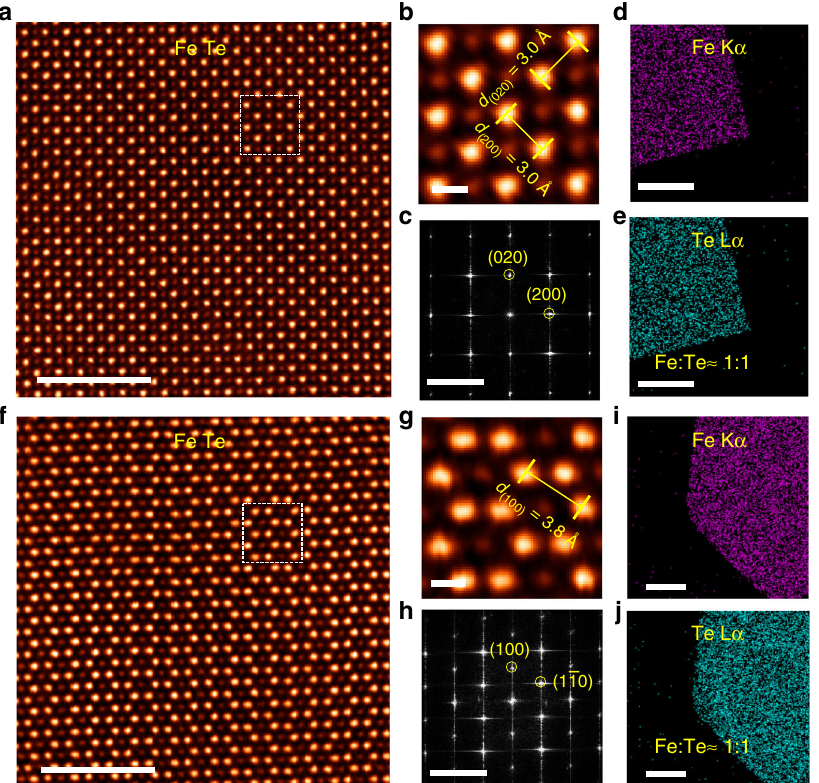
Fig. 3 Atomic morphology of tetragonal and hexagonal-shaped FeTe crystals. a , f Atomic-resolution STEM-ADF images of ( a ) tetragonal, and ( f ) hexagonal-shaped FeTe crystals. b , g The magni fi ed STEM images from the white box regions in a and f , respectively. c , h Corresponding FFT patterns of a and f , respectively. d , e , i , j EDS mapping of d and e tetragonal, and i , j hexagonal-shaped FeTe crystals. Scale bars: 5 nm in a , f ; 0.5 nm in b , g ; 5 nm − 1 in c , h ; 1 μ m in d , e and 500 nm in i , j